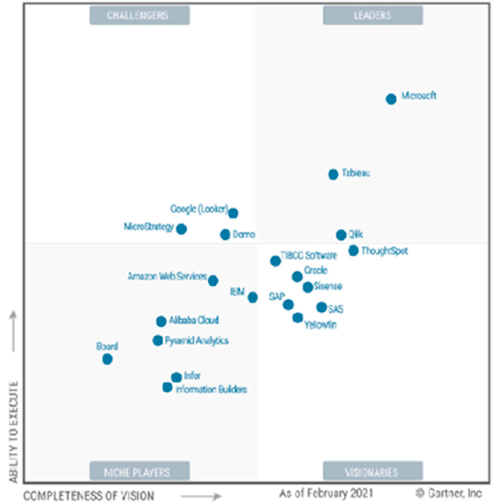
Figure 5. 2021 Gartner Magic Quadrant for Analytics and Business Intelligence Platforms.